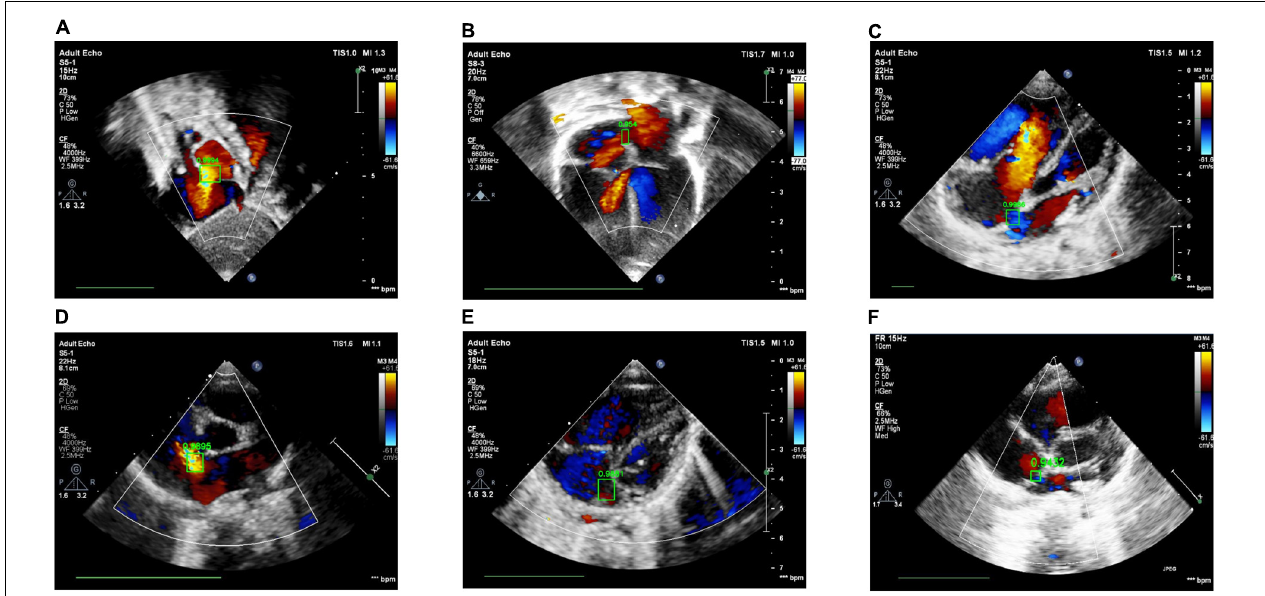
FIGURE 9 | Examples of success and failure cases. (A) ASD detected in the subAS view: bright red shows the transeptal flow with left-to-right shunt, (B) ASD detected in the A4C view: dark red in the center of the atrial septum indicates the occurrence of left-to-right shunt flow, (C) ASD detected in the LPS4C view: blue regions represent the transeptal flow with right-to-left shunt, (D) ASD detected in the PSAX view: bright red shows the transeptal flow with left-to-right shunt. (E) ASD detection of false positive, due to the confusion of similar structures and the failure of the cardiac anatomy segmentation stage; (F) ASD detection of true negative, due to the low confidence (0.9432 <